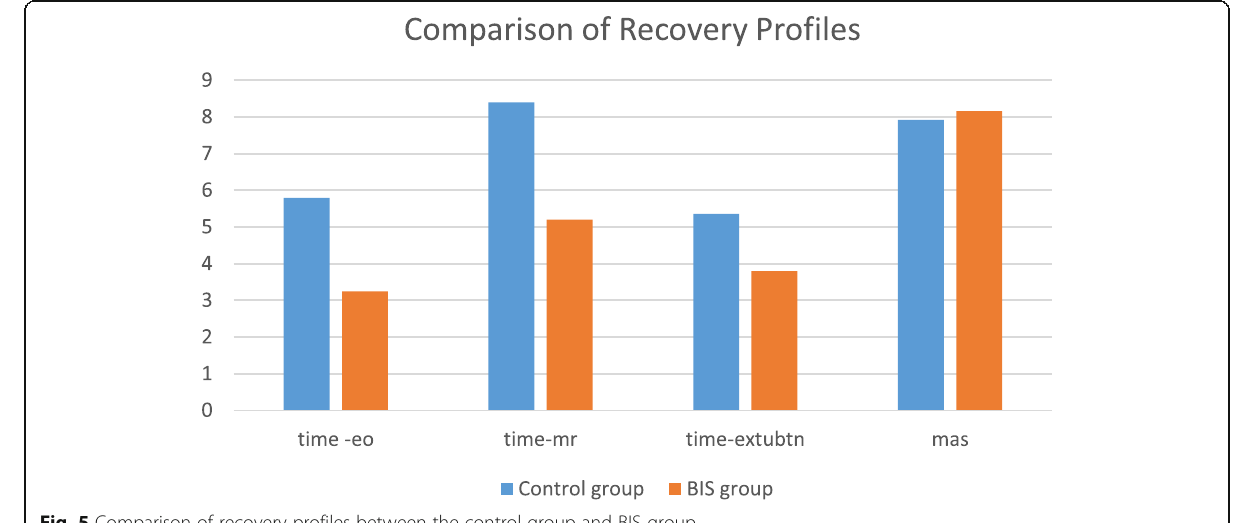
Fig. 5 Comparison of recovery profiles between the control group and BIS